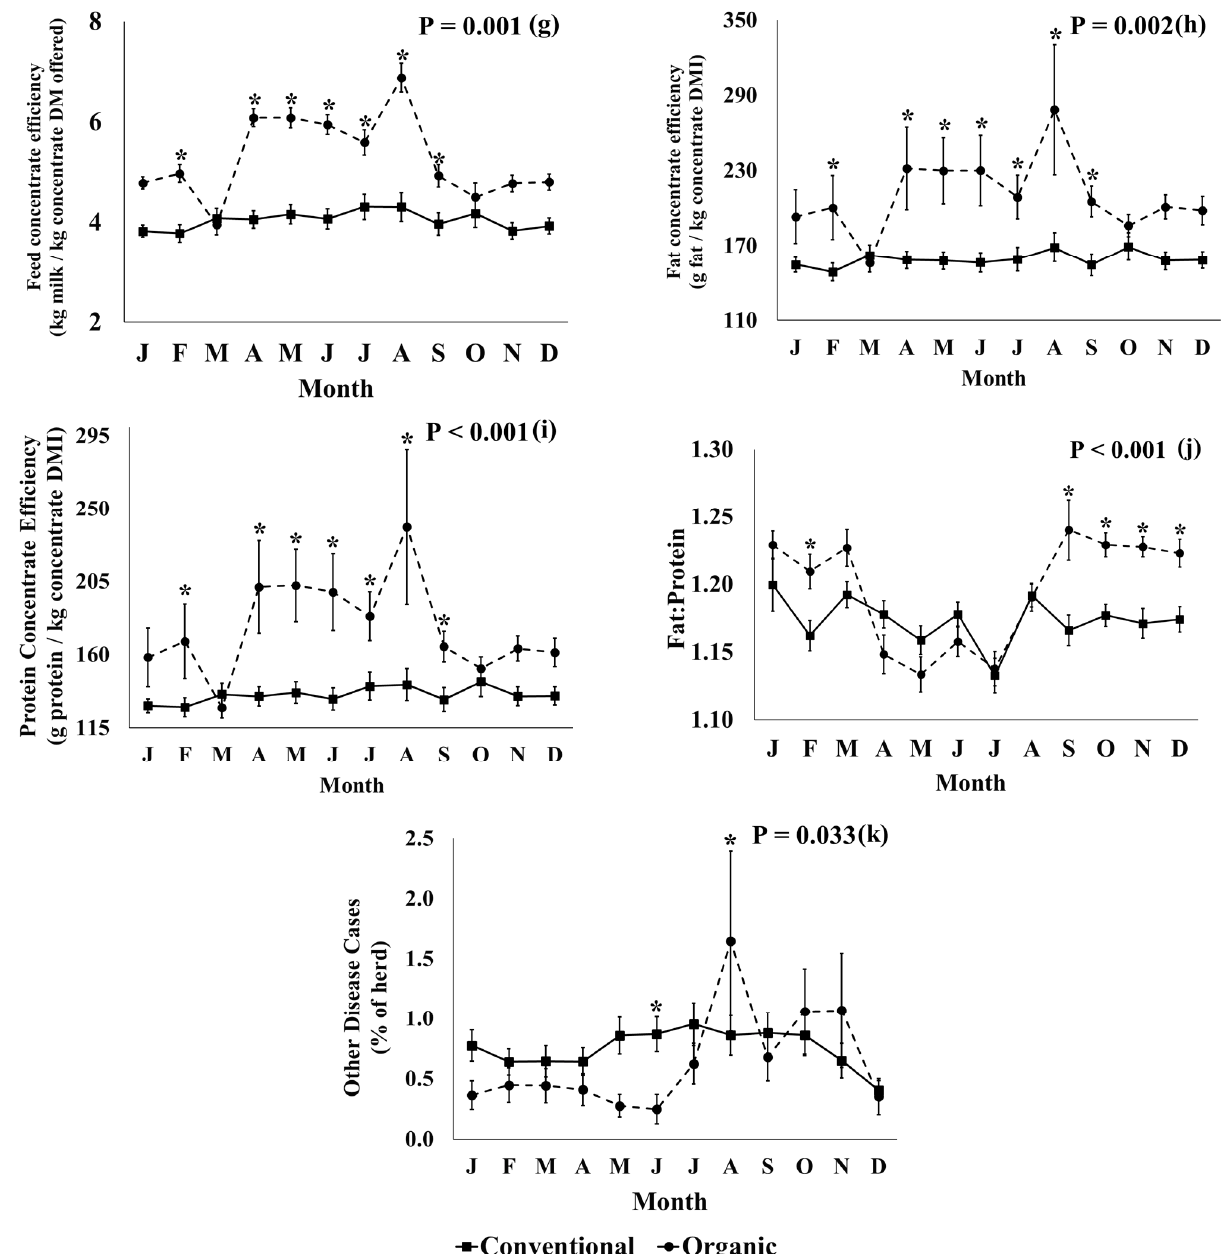
Figure 1. Feed efficiency and health parameters, where a significant ( p < 0.05) interaction between production system (conventional, solid line; organic, dotted line) and month was observed. Units used: kg output/kg DM o ff ered (panels ( a , d , g )), g output/kg DM o ff ered (panels ( b , c , e , f , h , i )), fat:pro- tein ratio of milk ( j ) and % of herd ( k ). Means were calculated from the measured values. *: signi fi - cant di ff erence between conventional and organic farms within the month ( p < 0.05). The error bars represent the standard error of the means.